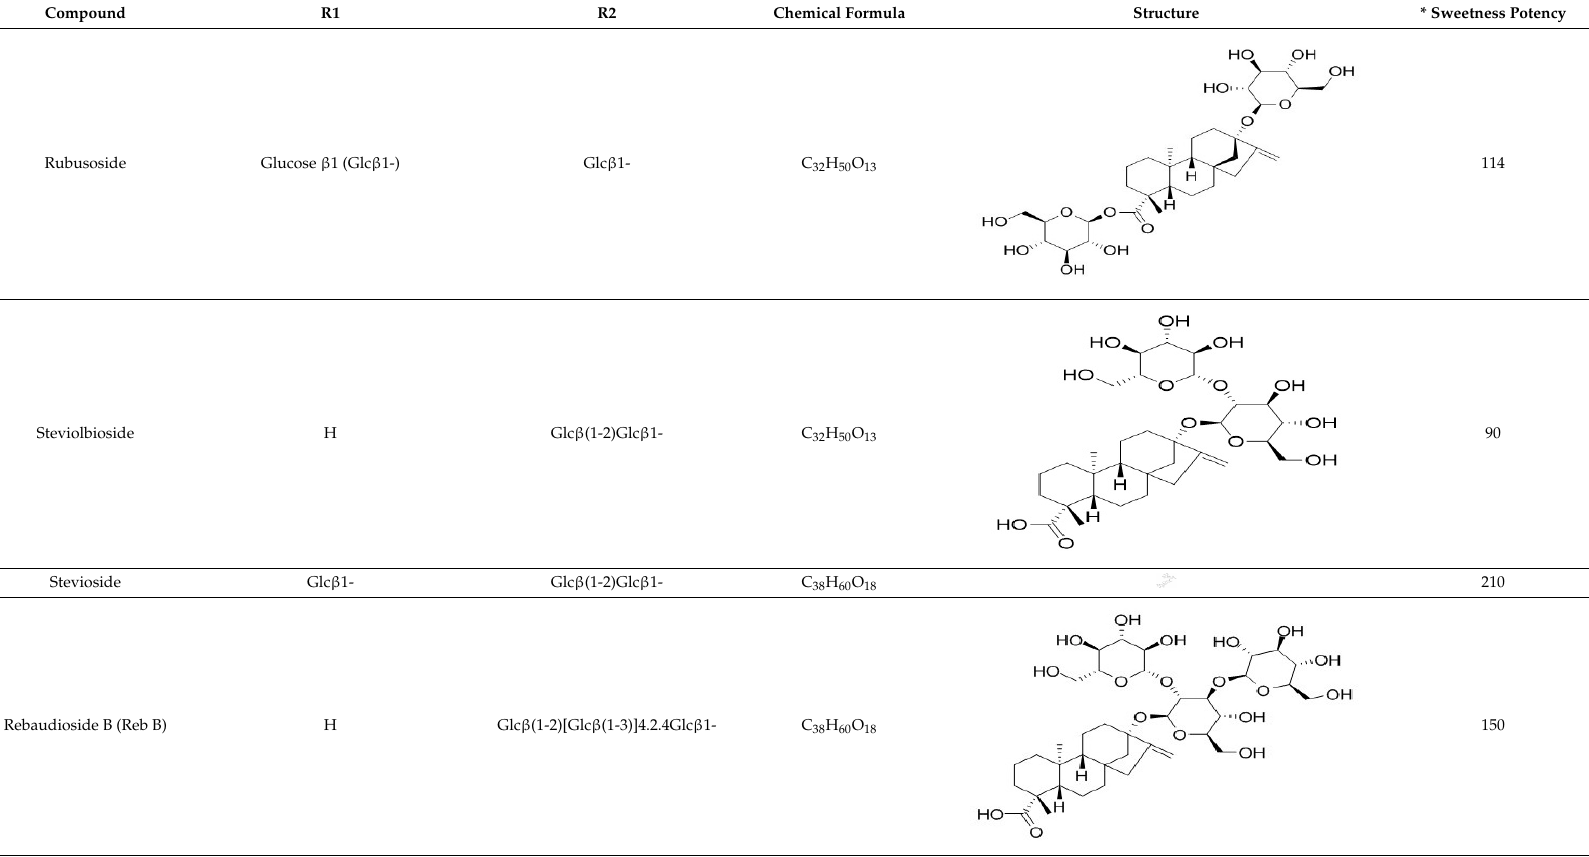
Table 4. Different compounds of steviol glycosides with varying groups at R1 and R2 positions [174,202,203]. Compound Chemical Formula Structure